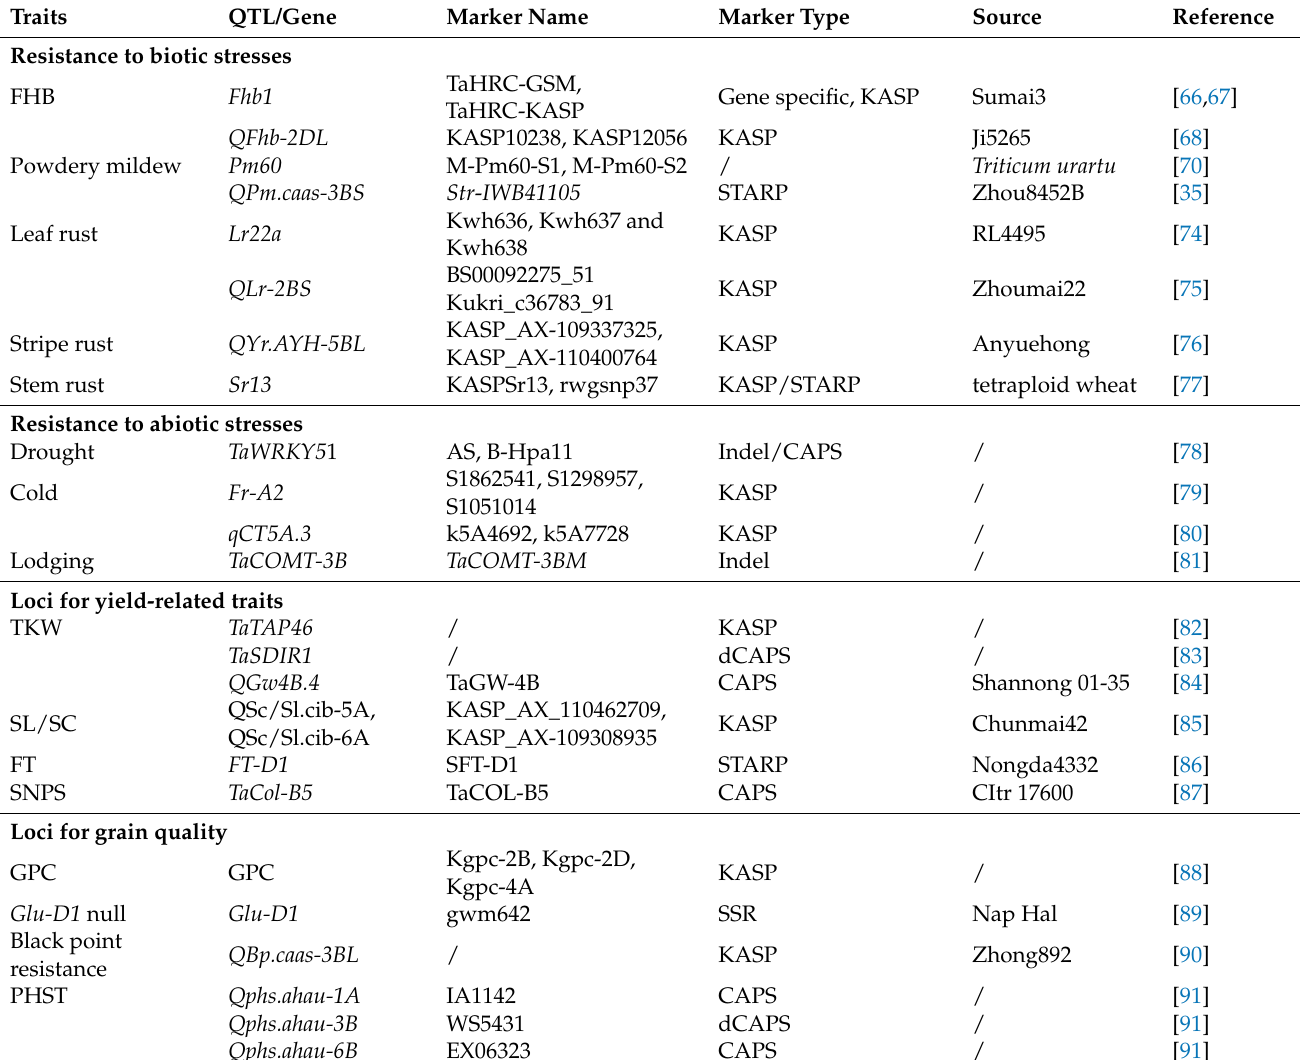
Table 1. Loci and linked or functional markers for some key